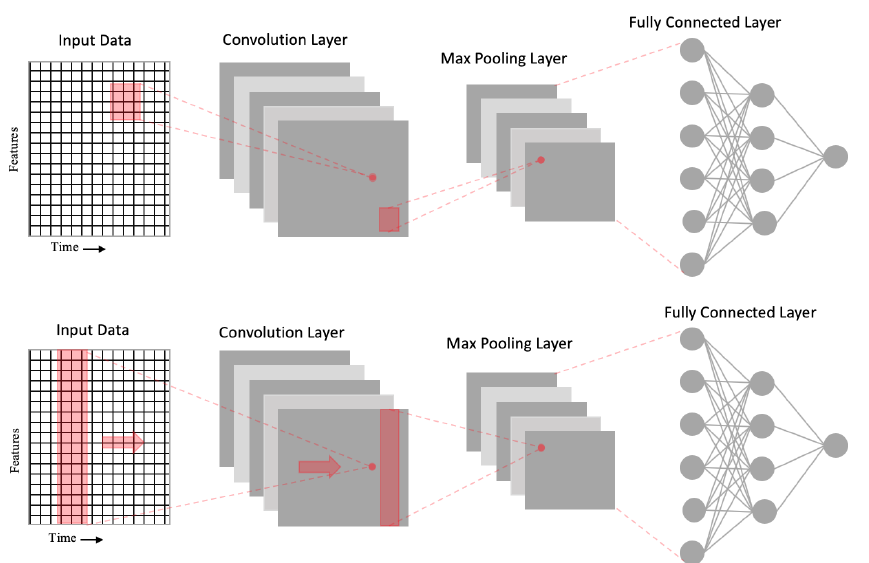
Figure 4. The top part of the figure illustrates a normal two dimensional convolutional neural network (CNN) with its convolutional layer and max pooling layer. The max pooling layer is subsequently flattened to feed the data into a fully connected layer. The bottom figure is a one-dimensional convolutional neural network (CNN1D) network where the filter is moving in only one direction to perform the convolution and max-pooling